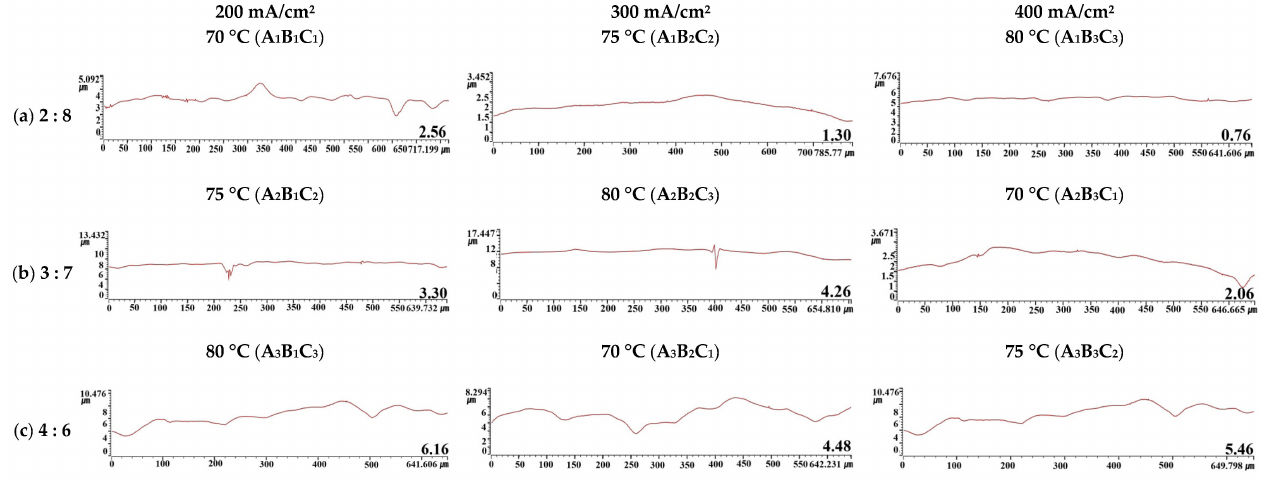
Figure 5. Height differences between mountains and valleys after electropolishing in an electrolyte containing sulfuric acid (95 wt%) and phosphoric acid (85 wt%), Unit: µ m. A 1 B 3 C 3 : the flattest, A 3 B 1 C 3 : the